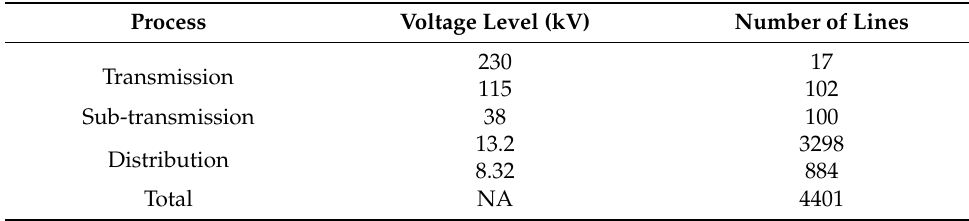
Table 9. Summary of the simulated electrical lines.